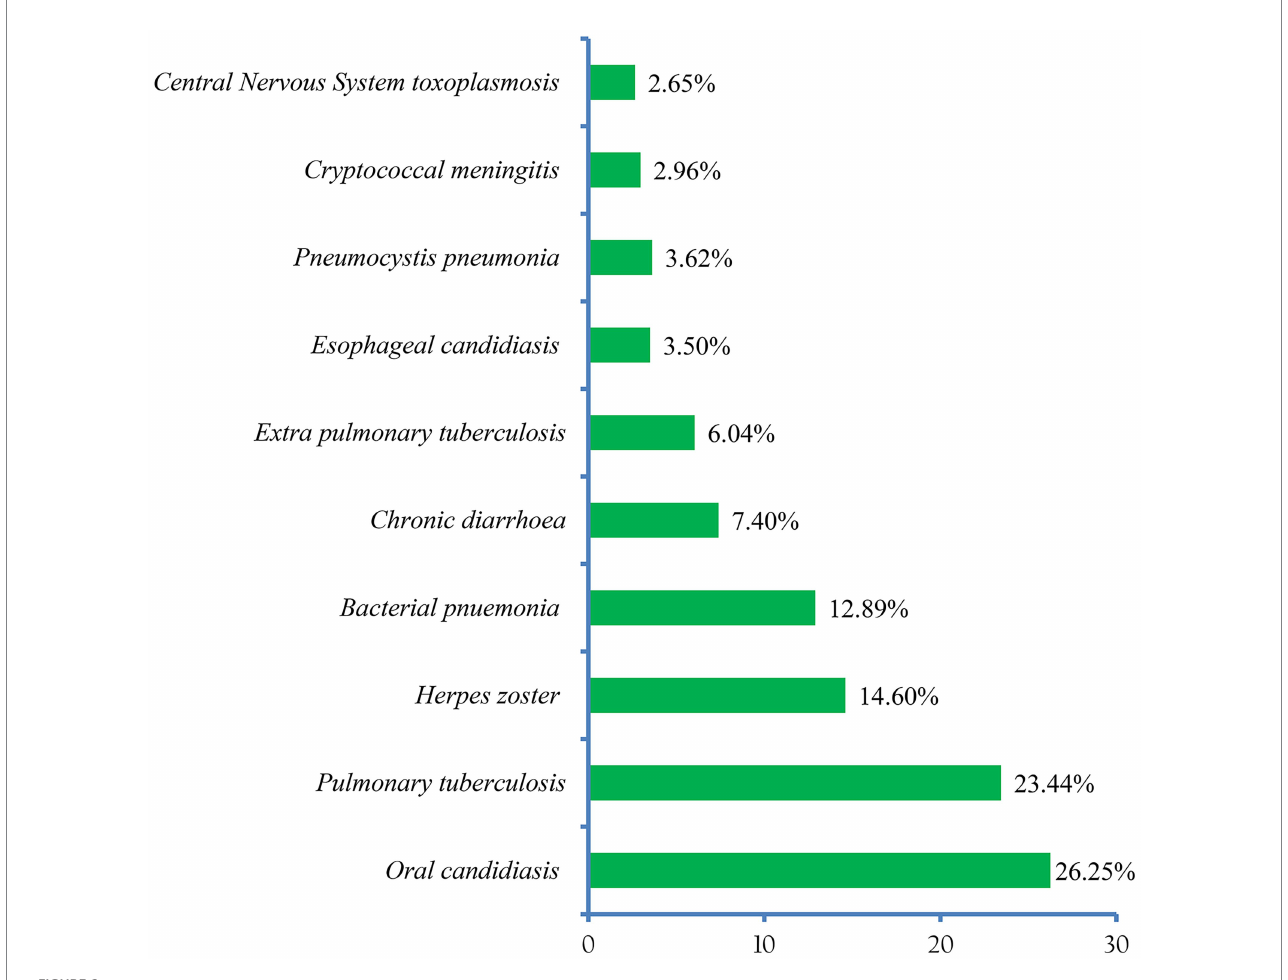
FIGURE 6 The top 10 most common OIs among adults receiving ART in